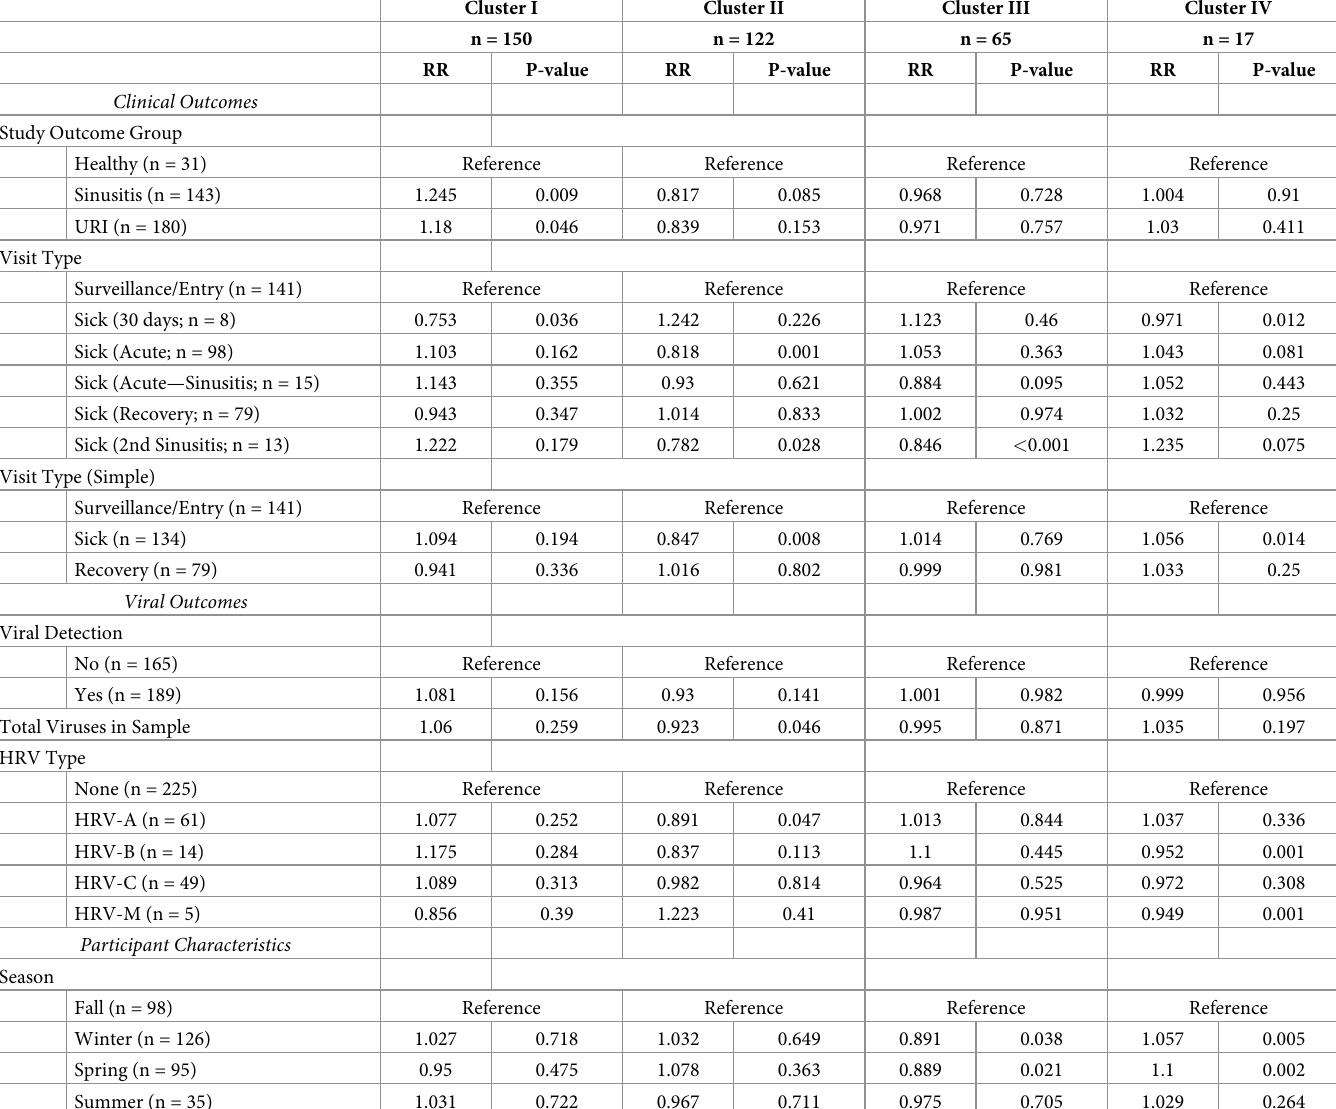
Table 4. Microbiological, viral and clinical factors are differentially associated with microbiota